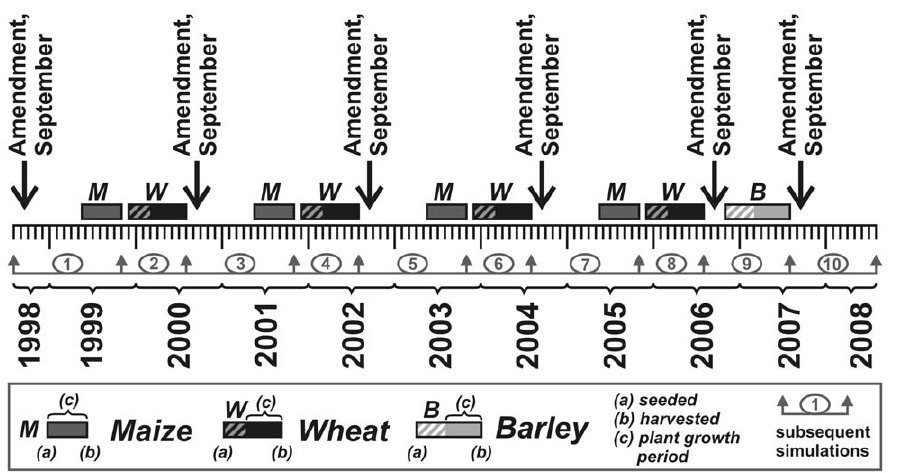
Figure 6. Overview of the field and simulation study. For wheat and barley the starting point of growth takes place after seeding.